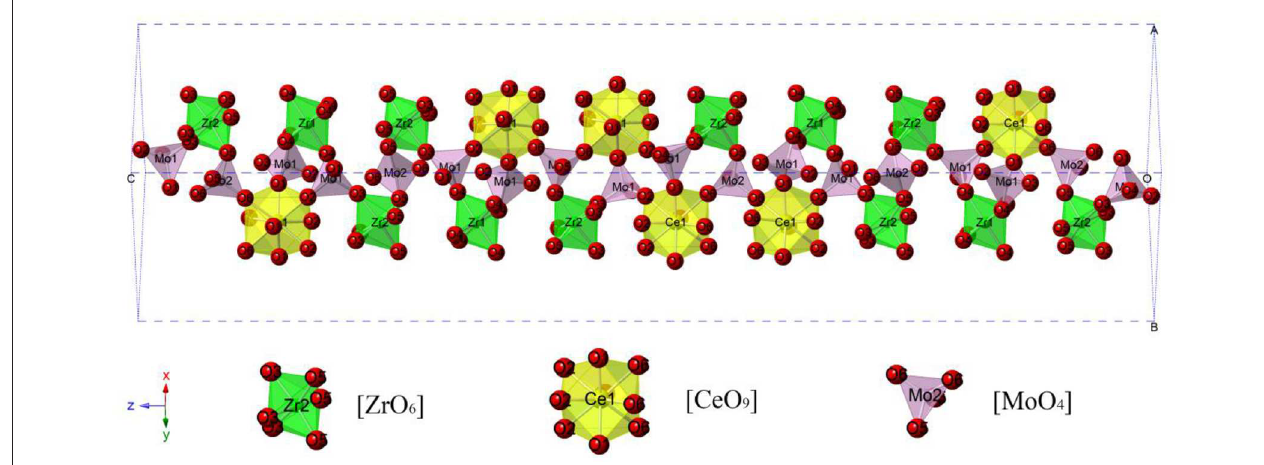
FIGURE 3 | The schematic of the crystal structure for Ce 2 (Zr 0.94 Sn 0.06 ) 3 (MoO 4 ) 9 ceramics.